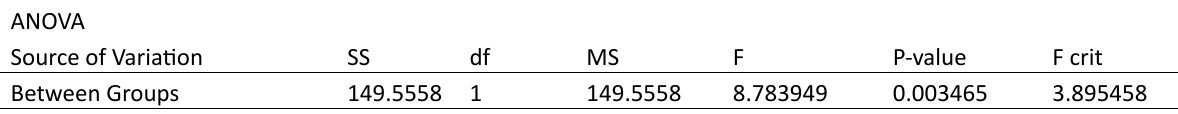
Table 1. BMI Summary Data Table 2. ANOVA results ANOVA Source of Variation